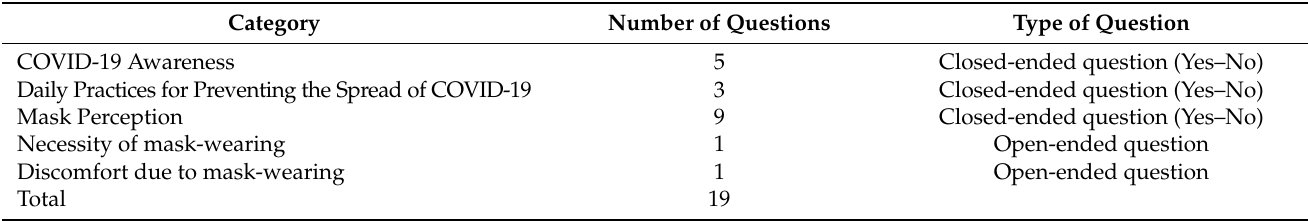
Table 2. Contents of questionnaire questions and types.